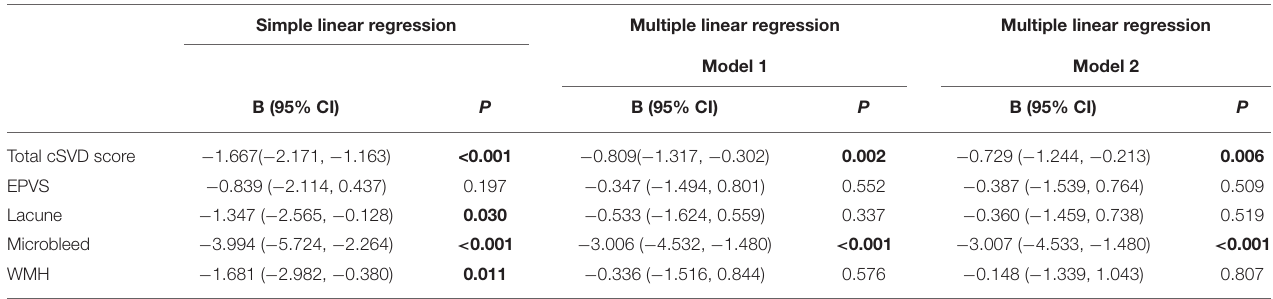
TABLE 4 | Association between cSVD and MoCA scores in the linear regression. Simple linear